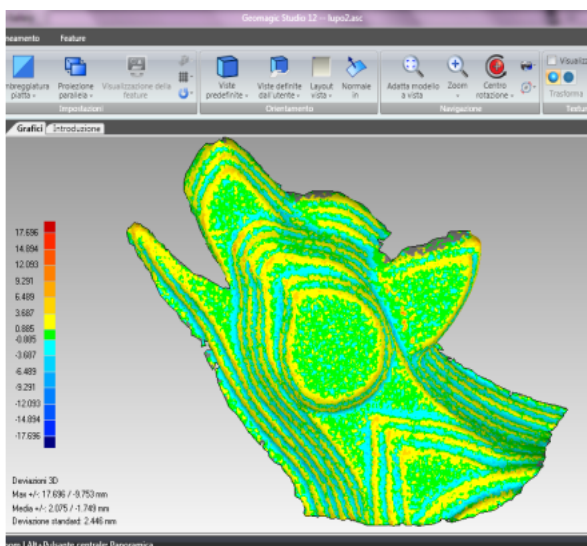
Figure 6. The deviations among the scan points and the model of the Wolf of Sila obtained by 5 aligned scans acquired by using the VIVID 300 scanner.